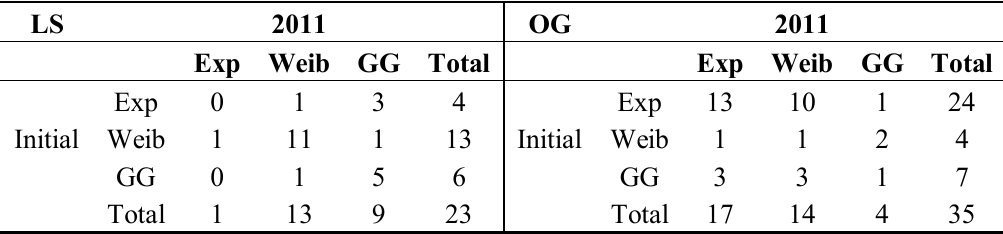
Table 3. Number of late-successional (LS) and old-growth (OG) plots, at initial measurement and in 2011, that were best fit by the exponential (Exp), Weibull (Weib), and generalized gamma (GG) distributions, with model fit evaluated by AIC.